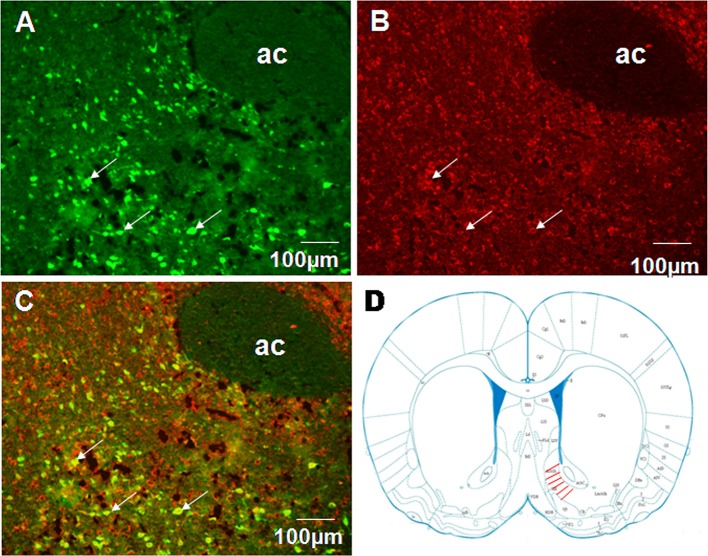
Co-localization of retrograde labeling from VMH and NUCB2/nesfatin-1 in the neurons of the shell of NAc. (A) The distribution of fluorogold retrotracing from the VMH to the NAc, white arrows indicate FG-labeled neurons, (B) The expression of NUCB2/nesfatin-1 in the NAc, white arrows indicate nesfatin-1positive neurons, (C) Double visualization of fluorogold and nesfatin-1 in NAc shell, white arrows indicate co-labeling of FG and nesfatin-1 in some neurons, (D) Schematic drawing illustrating the position of immunohistochemical figures in the NAc. Scale bars, 100 μm. Ac, core of NAc.